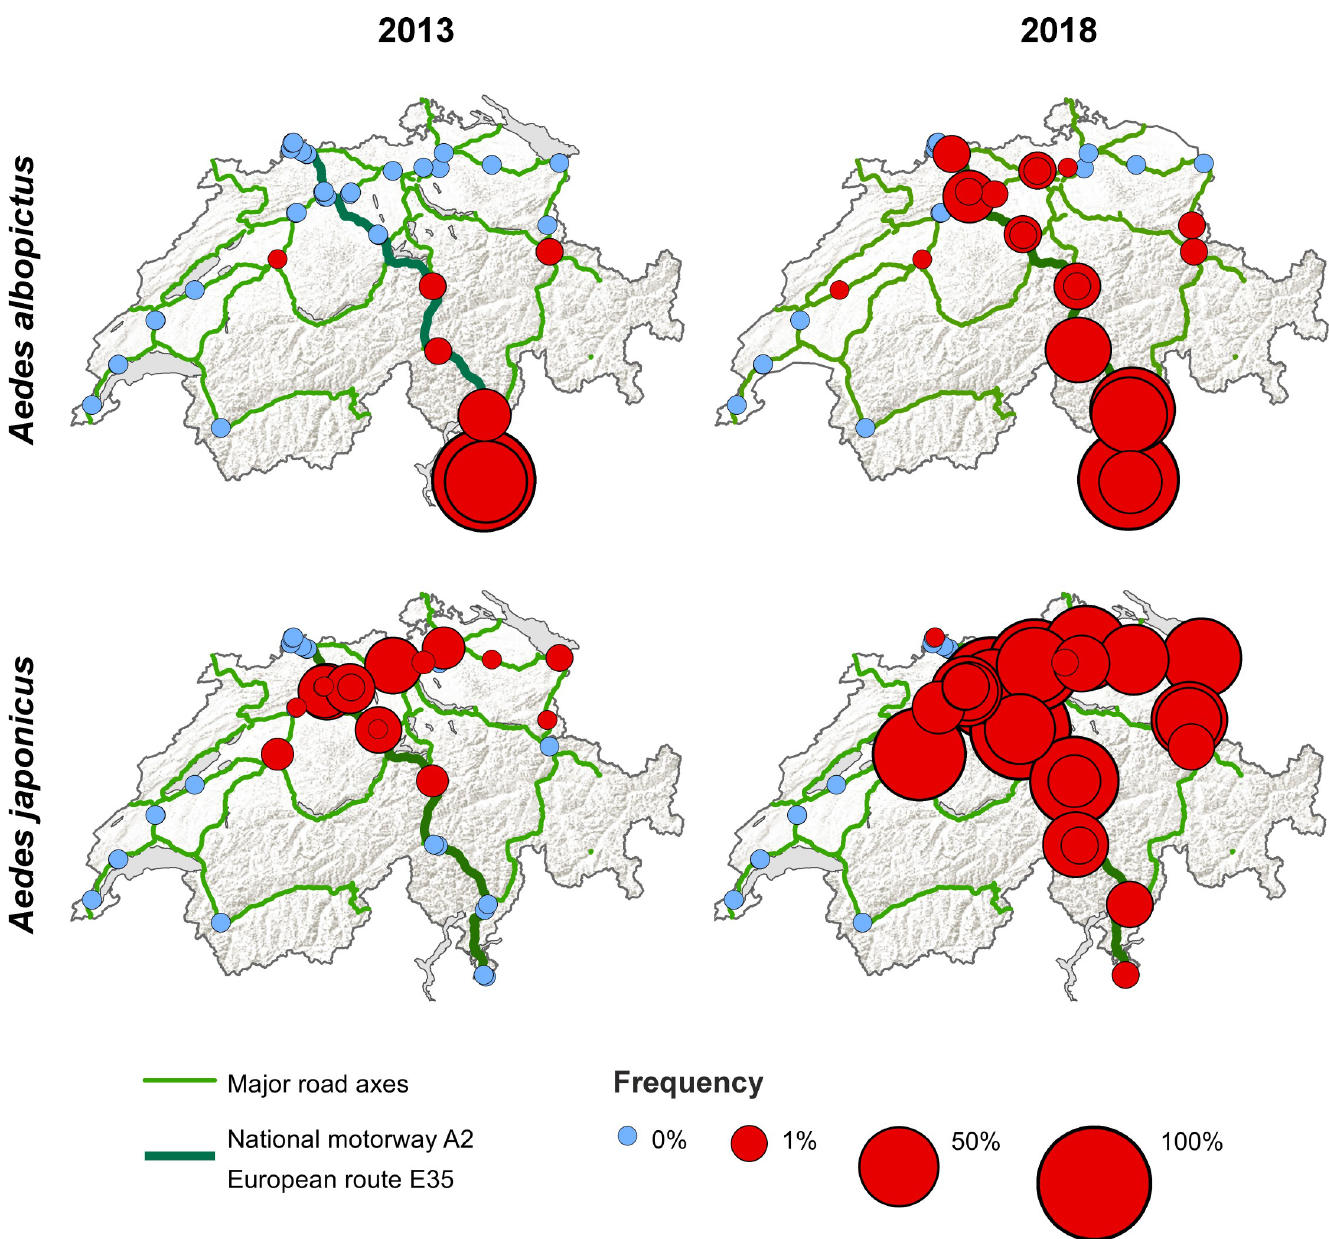
Fig 5. Distribution and frequency of Aedes albopictus and Ae . japonicus along main Swiss traffic axes in 2013 and 2018. Each circle represents a site while the colour and size of the circle indicates the frequency of positive ovitraps at that site. Missing slats were excluded from the analysis. Map source: Swiss Federal Office of Topography (swisstopo) and Swiss Federal Statistical Office, Section Geoinformation (GEOSTAT).